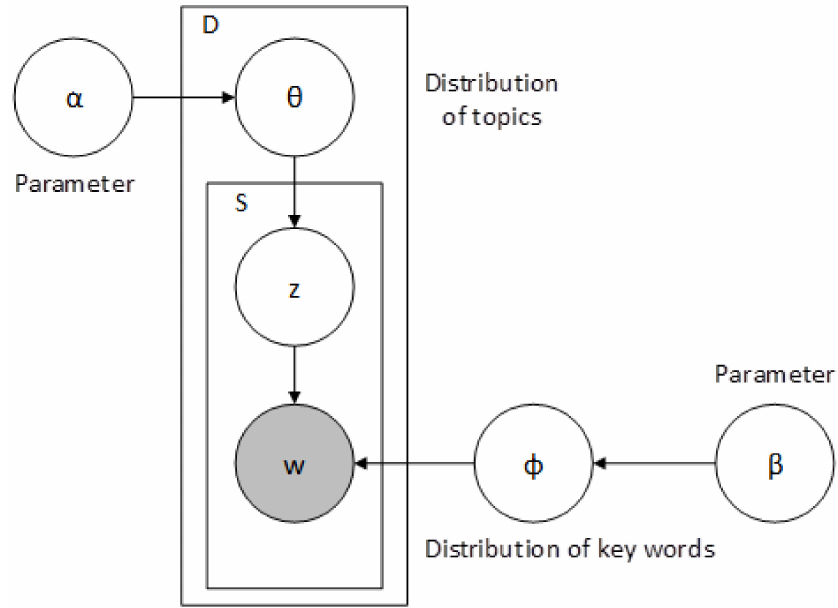
Figure 1. The LDA